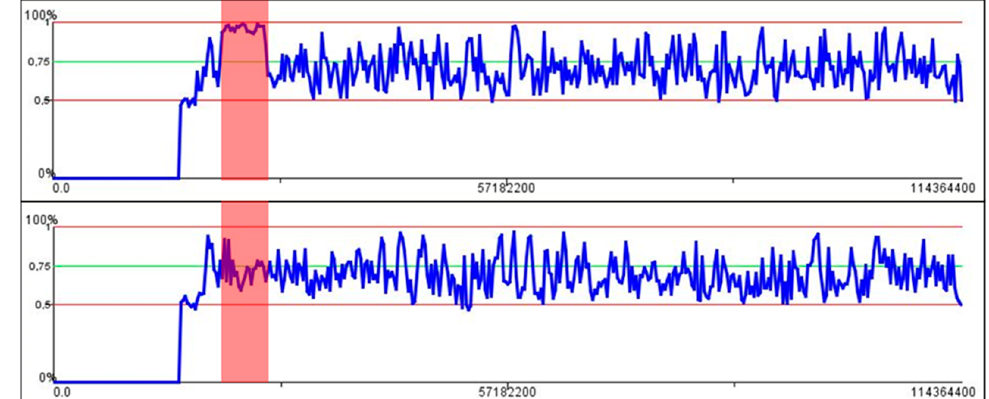
Figure 2. Homozygous area on chromosome 13 of the patient ( above ) and the same region in a control patient ( bottom ) are highlighted in red. In the patient, a plateau at 100% can be seen, which means that in this range all detected variants are present with a frequency of 100%